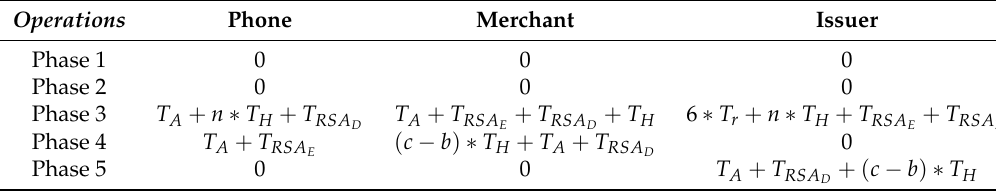
Table 8. The extra operations of EOPMA, comparing to